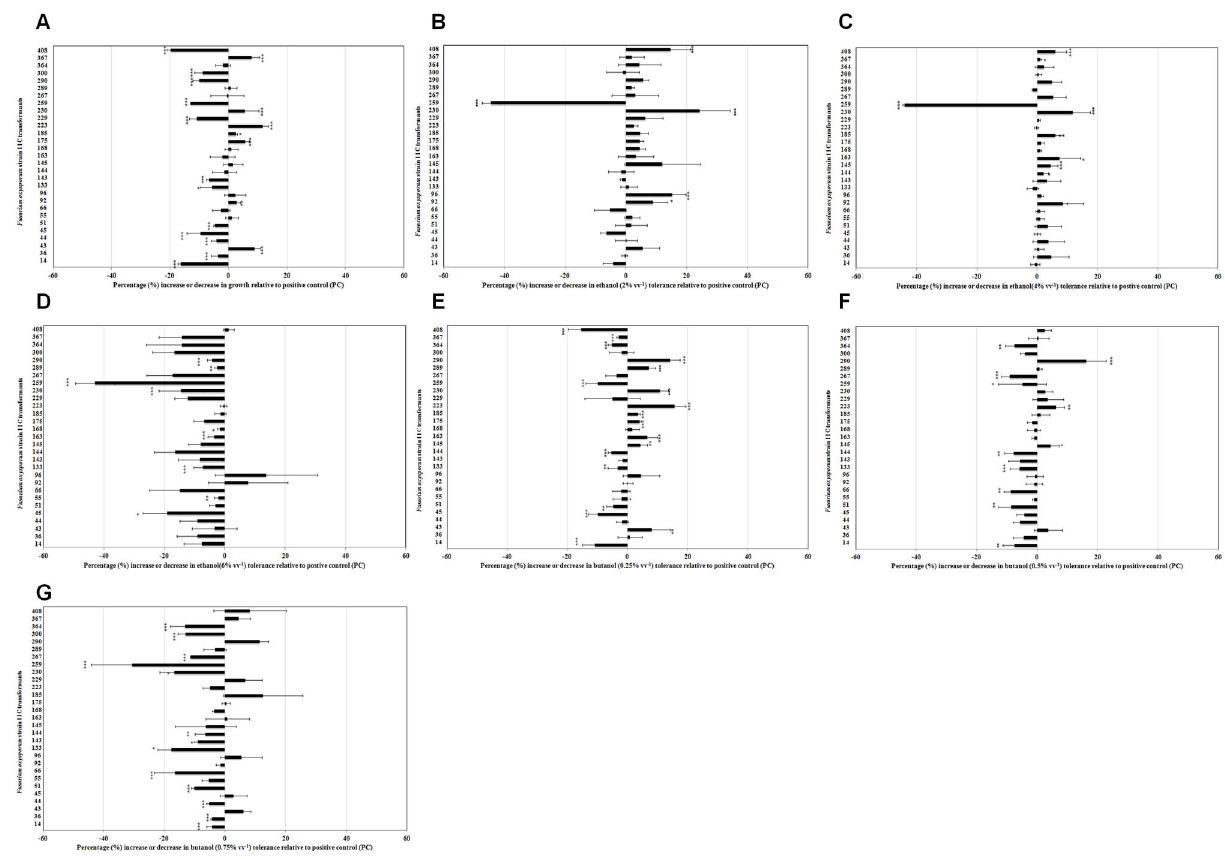
Figure 2. Tertiary screening of Fusarium oxysporum strain 11C transformants ( n =29). Fungi were grown in minimal medium [37] supplemented with; no alcohol ( A ); 2% (vv -1 ) ethanol (ethyl alcohol; Sigma, UK) ( B ), 4% (vv -1 ) ethanol ( C ), 6% (vv -1 ) ethanol ( D ) or 0.25% (vv -1 ) butanol ( n -butanol; Sigma, UK) ( E ), 0.5% (vv -1 ) butanol ( F ) or 0.75% (vv -1 ) butanol ( G ) and incubated at 25°C for 7 days. Percentage increase or decrease in fungal growth relative to the positive control (wild-type strain 11C) was determined. Results represent the mean of three independent experiments and bars indicate SEM. Transformants significantly different from the positive control (wild-type strain 11C) are highlighted with an asterisk (level of significance: <0.050 *, <0.01**, <0.001***). doi: